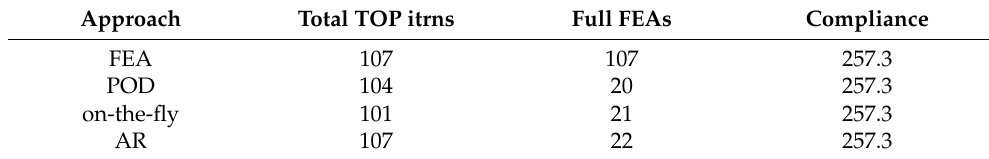
Table 2. Cantilever Beam 1: Results of each MOR approach as well as the classic implementation.